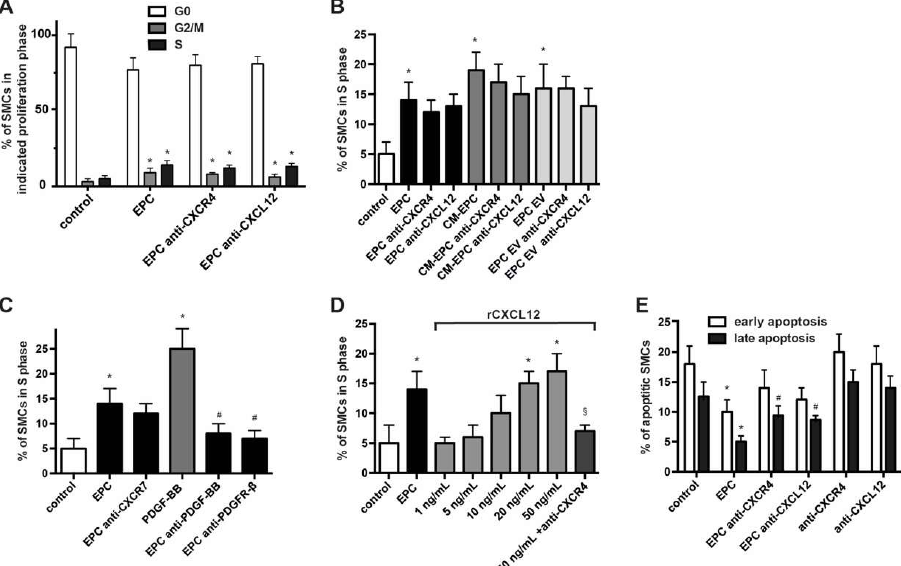
Figure 2. Higher concentration of CXCL12 induce proliferation of SMCs via CXCR4. ( A ) Flow cytometry-based cell cycle analysis of SMCs treated for 24 h with EPCs in the presence or absence of anti-CXCR4 and anti-CXCL12 Abs as indicated. * p < 0.05 vs. untreated SMCs (control); n = 5. ( B – D ) Analysis of SMCs in S phase as determined 24 h after treatment as indicated. * p < 0.05 vs. untreated